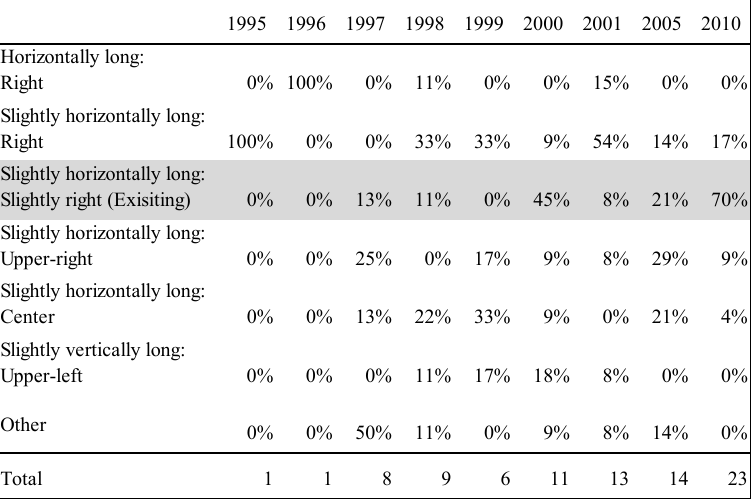
Table 1. Transitions of front-side shapes and lens positions in Good Design Award winning